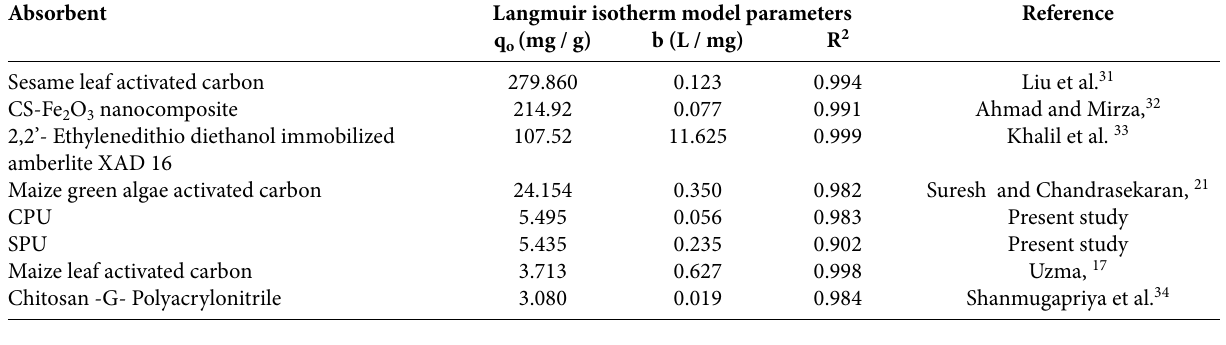
Table 2. Comparison of Langmuir isotherm model parameters for Pb (II) ion adsorption using various adsorbents